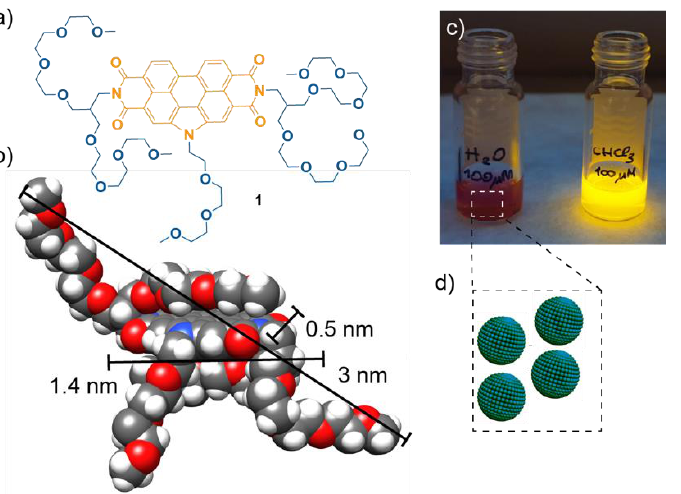
Figure 1. ( a ) Chemical structure and ( b ) modelized geometry of the amphiphilic N -annulated PBI 1 showing the molecular dimensions; ( c ) picture of the emission of solutions of 1 in water and in CHCl 3 under illumination at 365 nm; ( d ) schematic illustration of the globular aggregates formed by 1 in aqueous media.